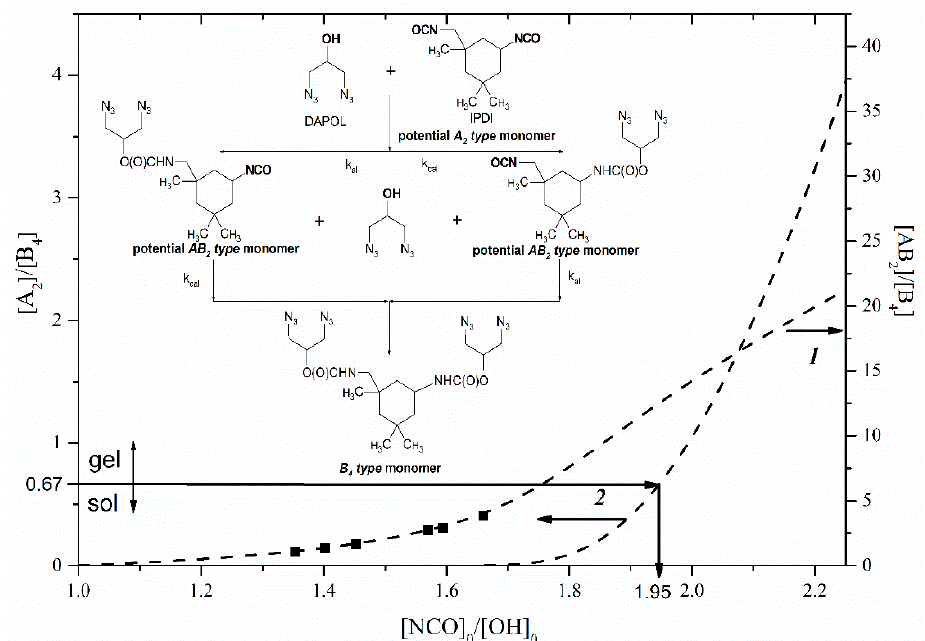
Figure 2. The simulated correlations (dashed line) between molar ratio of [ AB 2 ]/[ B 4 ] (right axis), [ A 2 ]/[ B 4 ] (left axis) and [NCO] 0 /[OH] 0 in reaction IPDI with DAPOL and corresponding experimental data (solid squares).